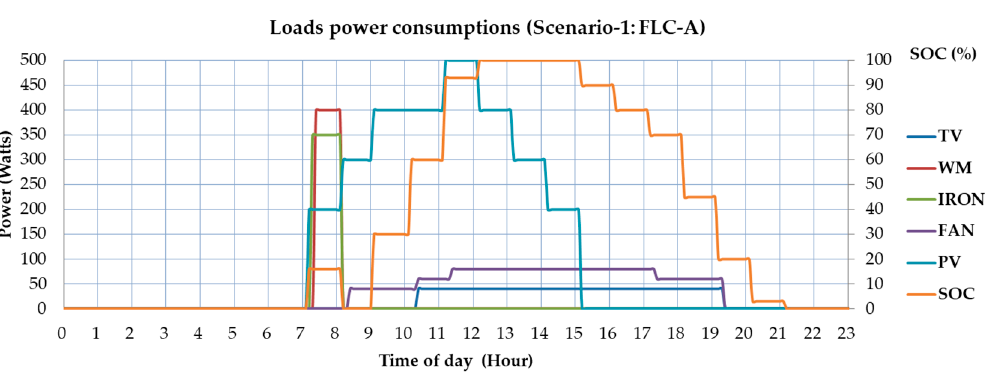
Figure 17. Power consumption of FLC-A in Scenario 1.